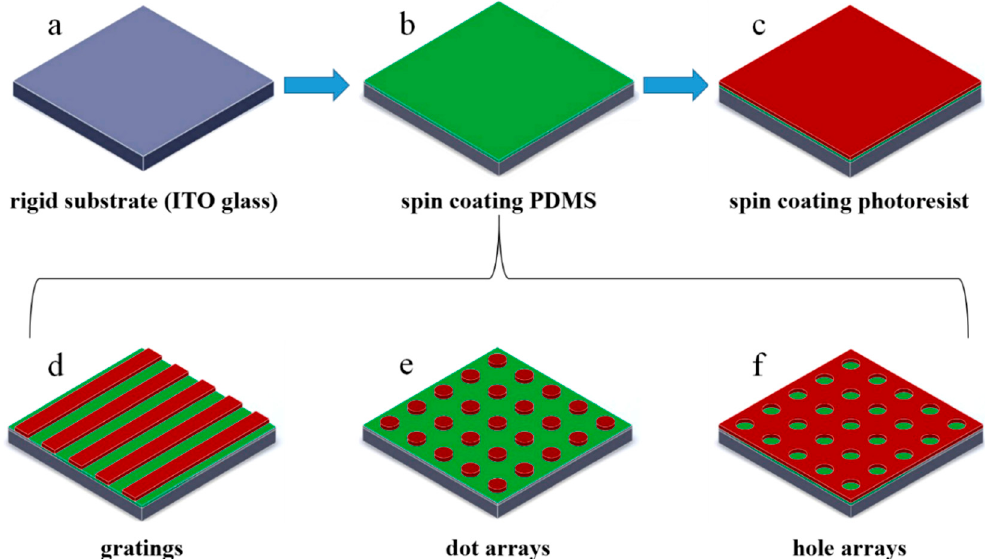
Figure 2. Schematic view of the fabrication process. ( a ) Cleaned ITO glass ( b ) ITO glass coated with a 60 μ m thick polydimethylsiloxane (PDMS) preploymer film by spin coating. ( c ) After the